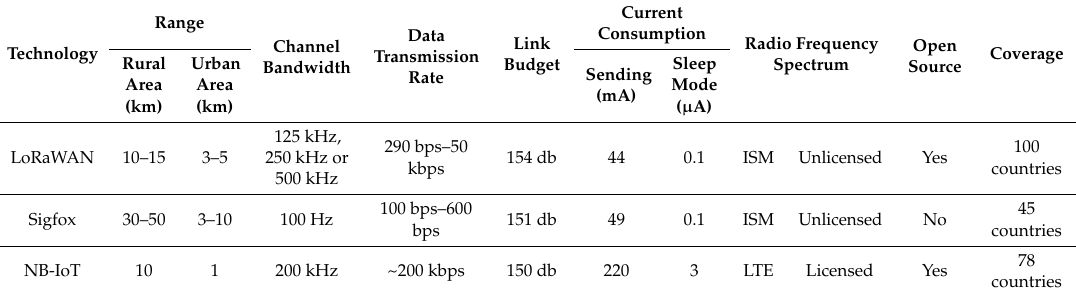
Table 1. Technical specifications of Low Power Wide Area Networks (LPWAN) communication technologies: LoRaWAN, Sigfox and